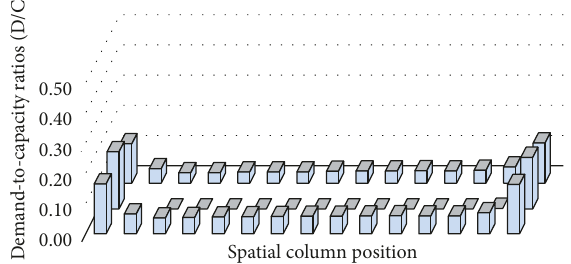
Figure 9: Demand to capacity ratios D/C: uneven distribution of inelastic response, CM coincident with